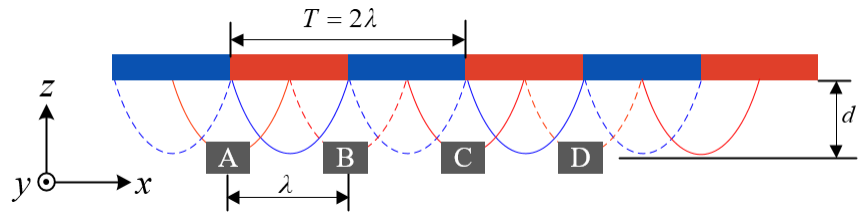
Figure 2. Sensor relative displacement measurement structure.